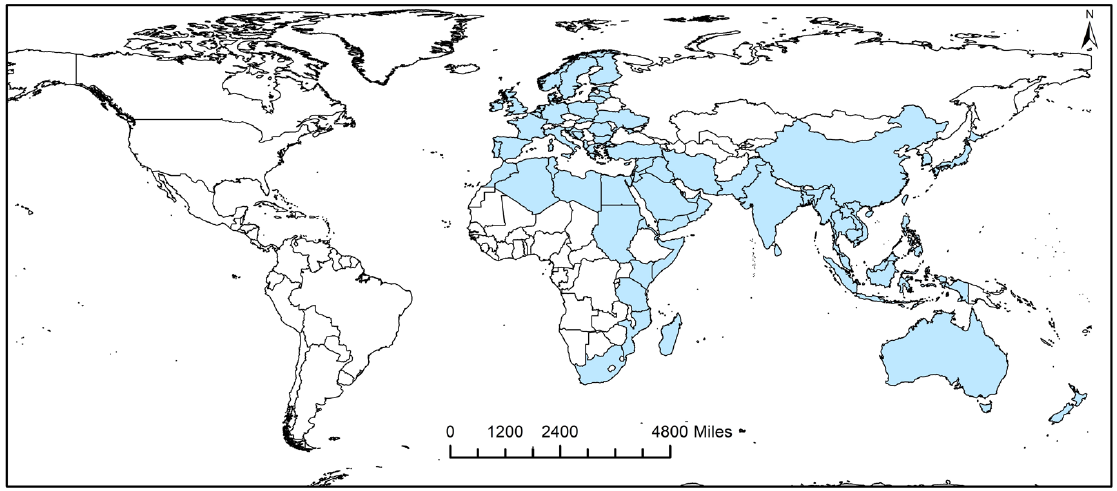
Figure 2. Scope of MSR.